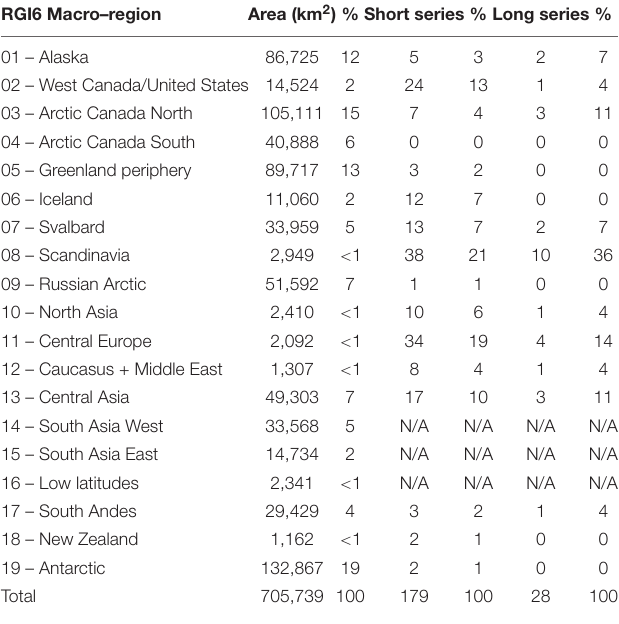
TABLE 1 | Glacier area within each RGI6 macro-region (RGI Consortium, 2017) compared with numbers of short ( > 4 years) and long ( > 29 years) series of winter, summer, and annual